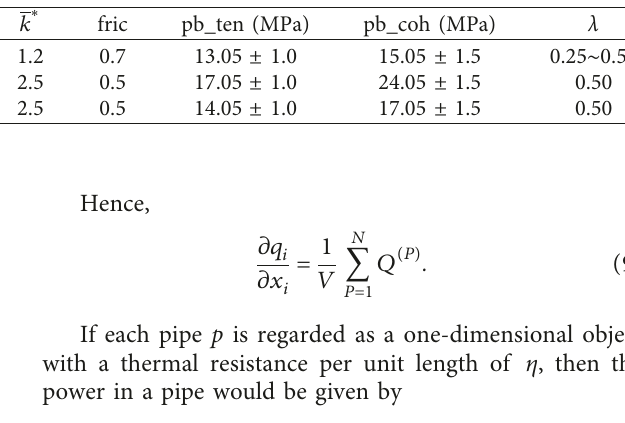
Table 2: Mesoparameters of material.